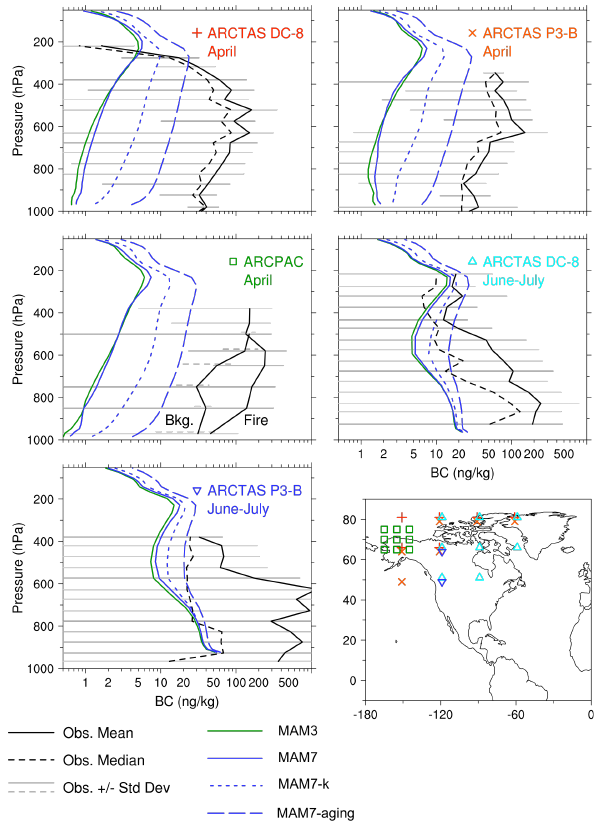
Fig. 16. Same as Fig. 15, but for BC vertical profiles at high lati- Figure 16. Same as Figure 15 but for BC vertical profiles at high latitudes from two other campaigns: ARCTAS (NASA Arctic Research of the Composition of the Troposphere tudes from two other campaigns: ARCTAS (NASA Arctic Research from Aircraft and Satellite), and ARCPAC (NOAA Aerosol, Radiation, and Cloud of the Composition of the Troposphere from Aircraft and Satellite) Processes affecting Arctic Climate). Observations are from the NOAA group for and ARCPAC (NOAA Aerosol, Radiation, and Cloud Processes af- ARCPAC, and from the University of Tokyo and University of Hawaii groups for fecting Arctic Climate). Observations are from the NOAA group ARCTAS. for ARCPAC and from the University of Tokyo and University of Hawaii groups for